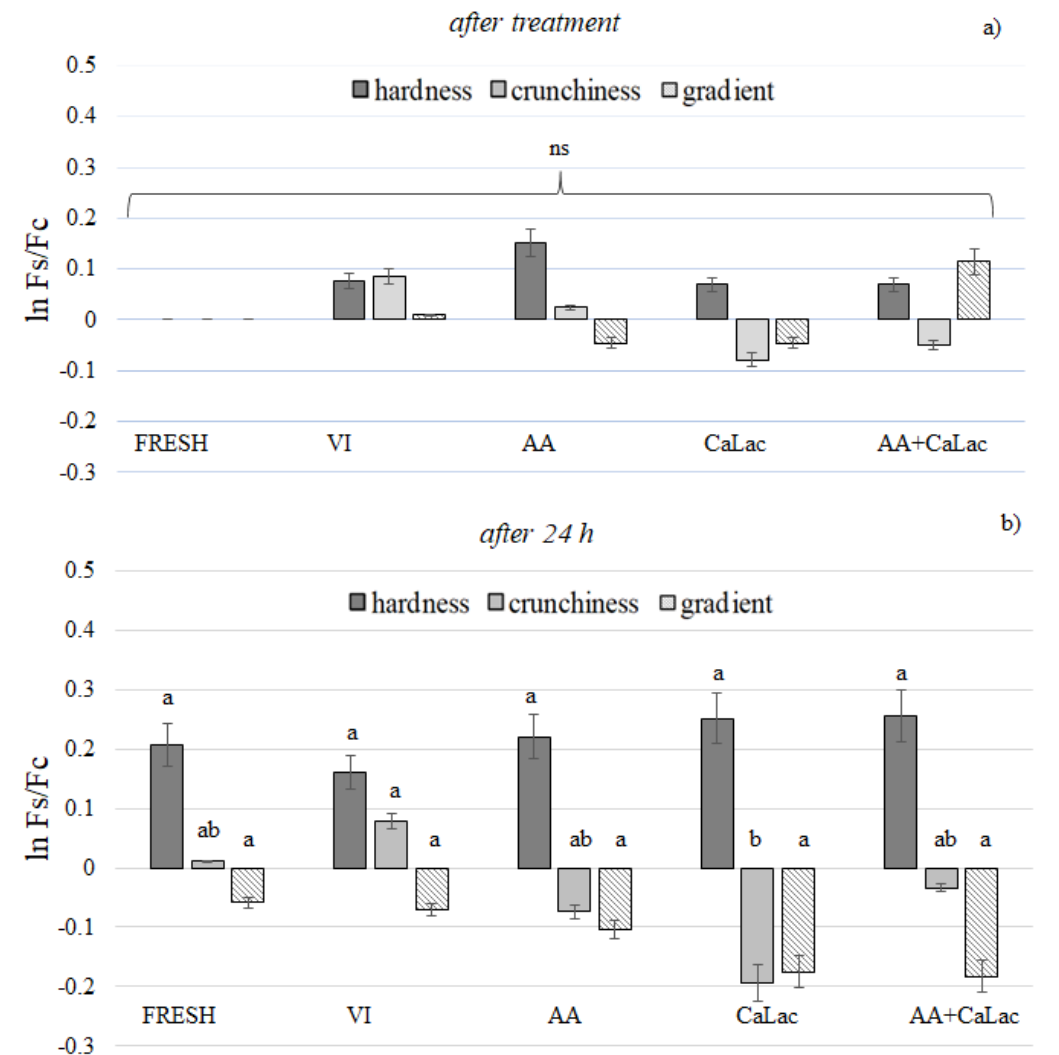
Figure 2. Hardness, crunchiness, and gradient of apple vacuum impregnated with different solutions ( a ) immediately after impregnation and ( b ) after 24 h storage at room temperature. The results are expressed as ln Fs/Fc, where Fs is the texture parameter value of the impregnating fruit and Fc is the texture parameter value of the fresh/control fruit (at time 0). FRESH, control sample; VI, vacuum impregnated with isotonic solution; AA, VI with ascorbic acid; Ca-Lac, VI with calcium lactate; AA+CaLac, VI with both. Bars with different letters indicate significant differences among the samples at same sampling time.